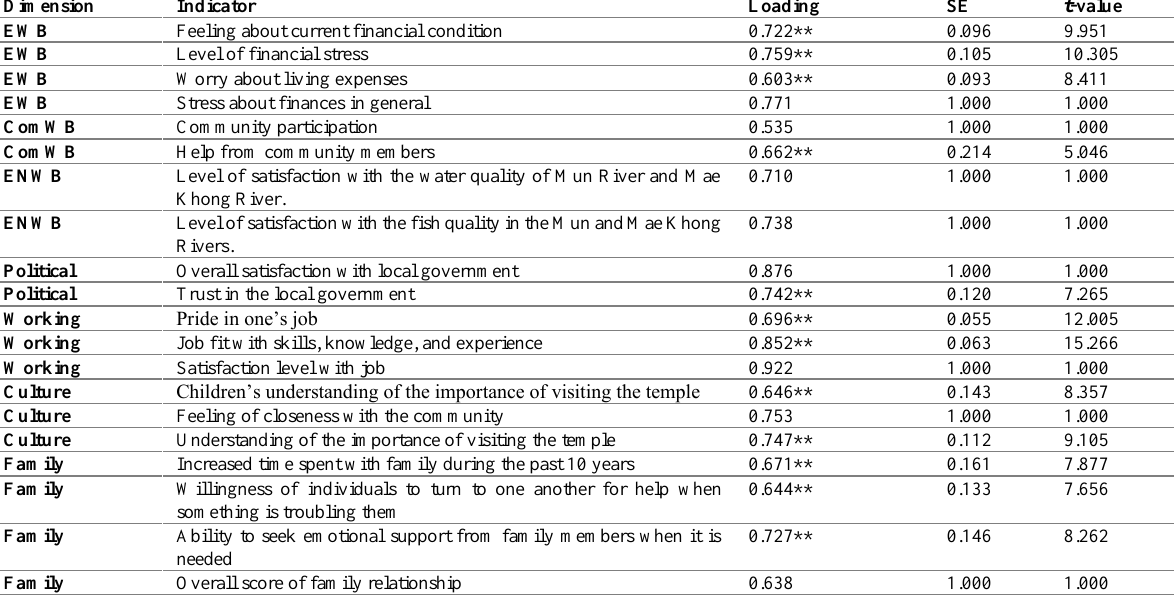
Table 4: Standardized factor loadings for indicators of the seven well-being dimensions in the CFA